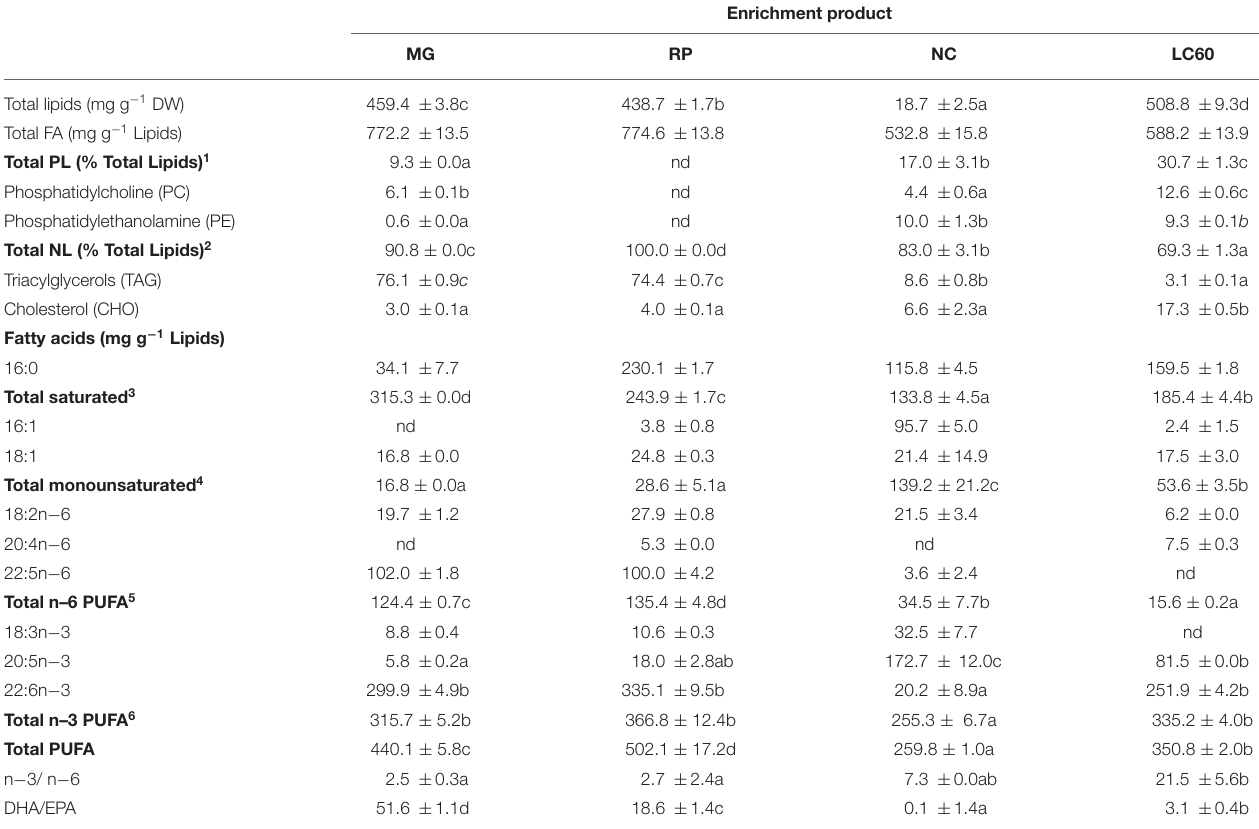
TABLE 1 | Total lipid and main lipid class content and fatty acid composition of the commercial products used for rotifer enrichment: Larviva Multigain (MG), Red Pepper (RP), Concentrated Nannochloropsis (NC), and marine phospholipids